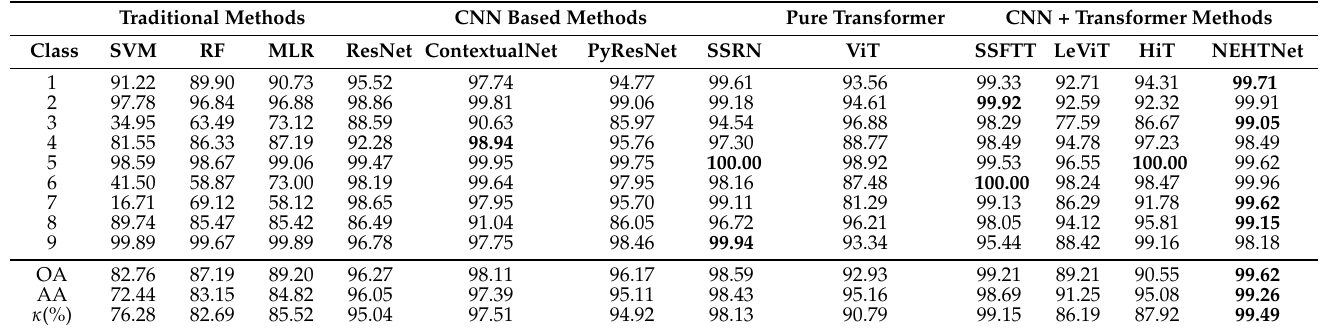
Table 6. Classification Accuracy of Different Methods for Labeled Pixels of The PU Data Set.